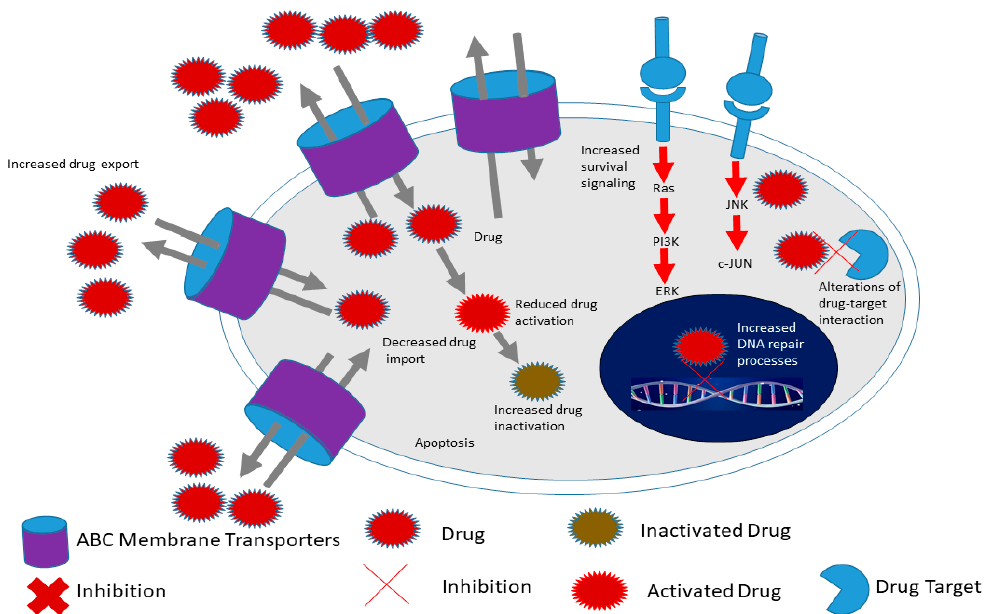
Figure 3. Hallmarks of cancer stem cells include increased expression of ATP-binding cassette (ABC) membrane transporters, enhanced survival signaling, increased drug in activation as well as increased DNA repair processes compared to cancer cells. This allows CSCs to survive conventional therapy and thus contribute to chemoresistance for example. Adapted from Senthebane et al. [3]. Cytotoxic drugs target rapidly growing cancer cells, making them ineffective against slow dividing or dormant CSCs [30]. Viale and colleagues demonstrated that leukemia CSCs proliferate at a much lower rate than other cancer cells [119]. Therapies that target cancer cell cycling would therefore be ineffective against CSCs. Therapeutic agents such as paclitaxel would be unable to be less effective against slow dividing CSCs [120]. In addition, several studies demonstrate that CSCs show enhanced DNA damage repair capacity, with phosphorylation of repair enzymes observed in cancers such as breast and gliomas [121,122]. CSCs including glioma stem cells demonstrate great abilities at ROS scavenging thus protecting themselves against oxidative DNA damage [123–125]. Therapy itself has been shown to selectively increase CSCs in tumors. For example, Rizzo and colleagues demonstrated that CSCs are enriched in ovarian tumors after chemotherapy [126]. In addition, Levina and coworkers showed that chemotherapy can lead to the propagation of CSCs in lung cancer [127]. Thus, chemotherapy only targets the rapidly proliferating cancer cells leaving the CSCs to propagate the tumor after therapy. Chen and colleagues demonstrated that the drug temozolomide (TMZ) activates CSCs to produce cancer cells after therapy [128]. Qiu and colleagues demonstrated that elevated O 6 -methylguanine DNA methyltransferase (MGMT) expression and activity in glioma stem-like cells were responsible for temozolomide resistance [129]. Kurtova and coworkers also demonstrated that blockage of tumor repopulation by CSCs is effective at attenuating therapy resistance in bladder cancer [130]. Saito and colleagues demonstrated that inducing cell cycle re-entry through treatment with granulocyte colony-stimulating factor (G-CSF) allows normal chemotherapy to eliminate cancer cells effectively [131]. In addition, the induction of CSCs differentiation has been used successfully to increase CSCs sensitivity to commonly used cancer drugs. Lombardo and coworkers induced colorectal CSCs terminal differentiation via the use of bone morphogenic protein 4 (BMP4) and observed increased CSCs sensitization to standard chemotherapy [132]. Wang and coworkers used silibinin, which blocks colon CSCs self-renewal, resulting in reduced